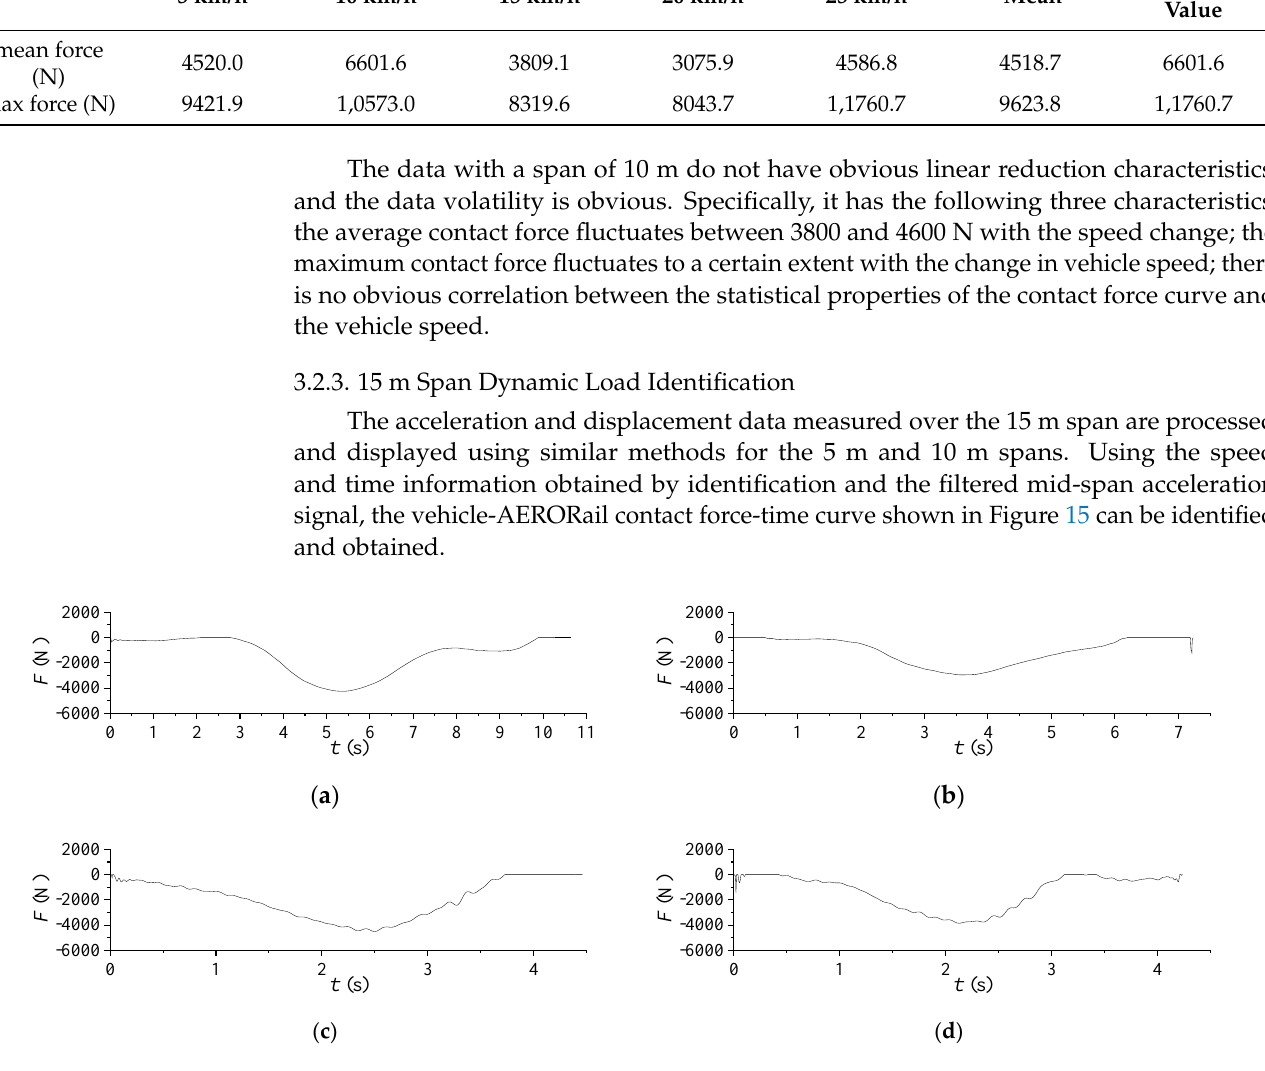
Figure 15. The contact force identification result of the 15 m span. ( a ) 5 km/h, ( b ) 10 km/h, ( c ) 15 km/h, ( d ) 20 km/h.